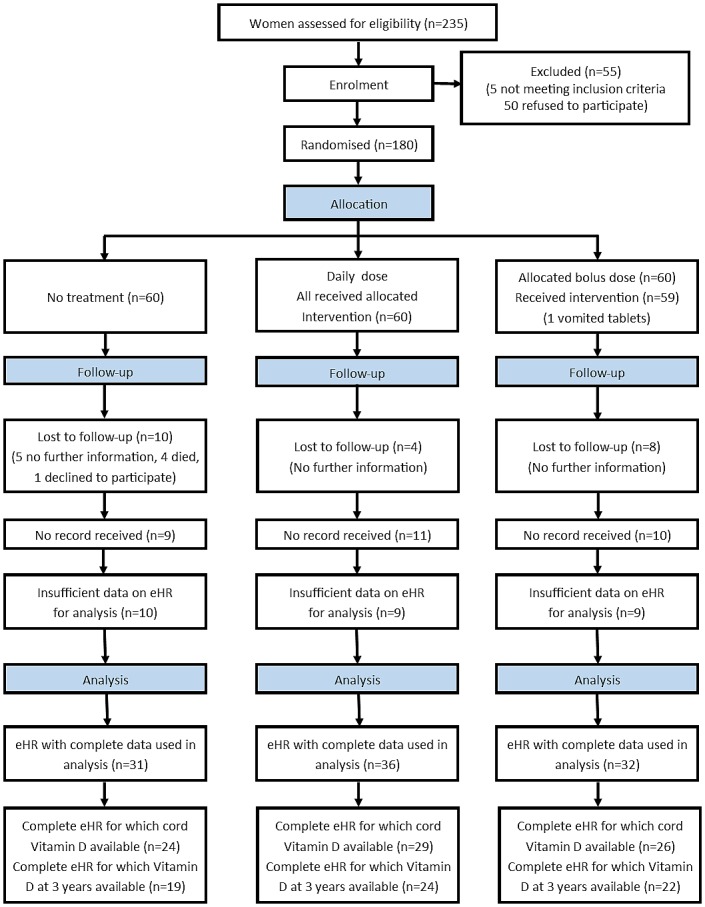
CONSORT flow diagram.